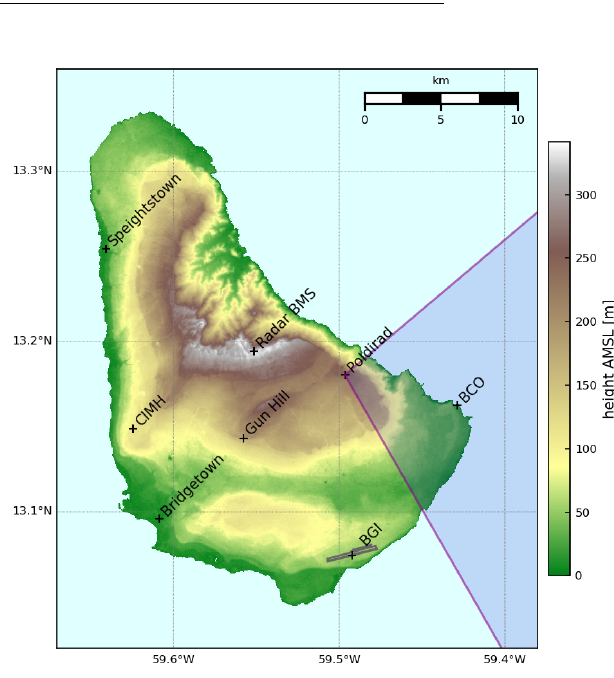
Antenna diameter Beamwidth (half power) ca. 1.0 ◦ Modes short range long range Peak transmit power at antenna feed ca. 145kW ca. 185kW Pulse length 1.0µs 2.0µs Pulse repetition frequency 1150Hz 400Hz Maximum range 130km 375km Range resolution 150m 300m Polarization mode alternate HV hybrid Sensitivity (dBz @ km) − 20@10, − 5@50, 2@120